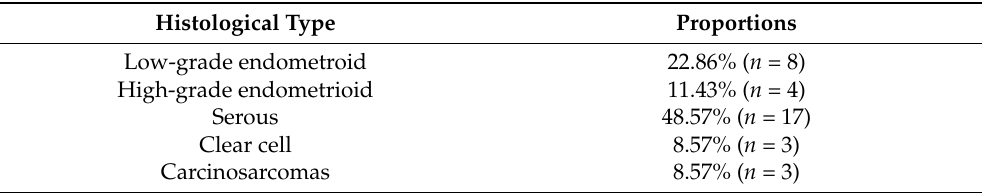
Table 4. p53-mutated cases according to their histological